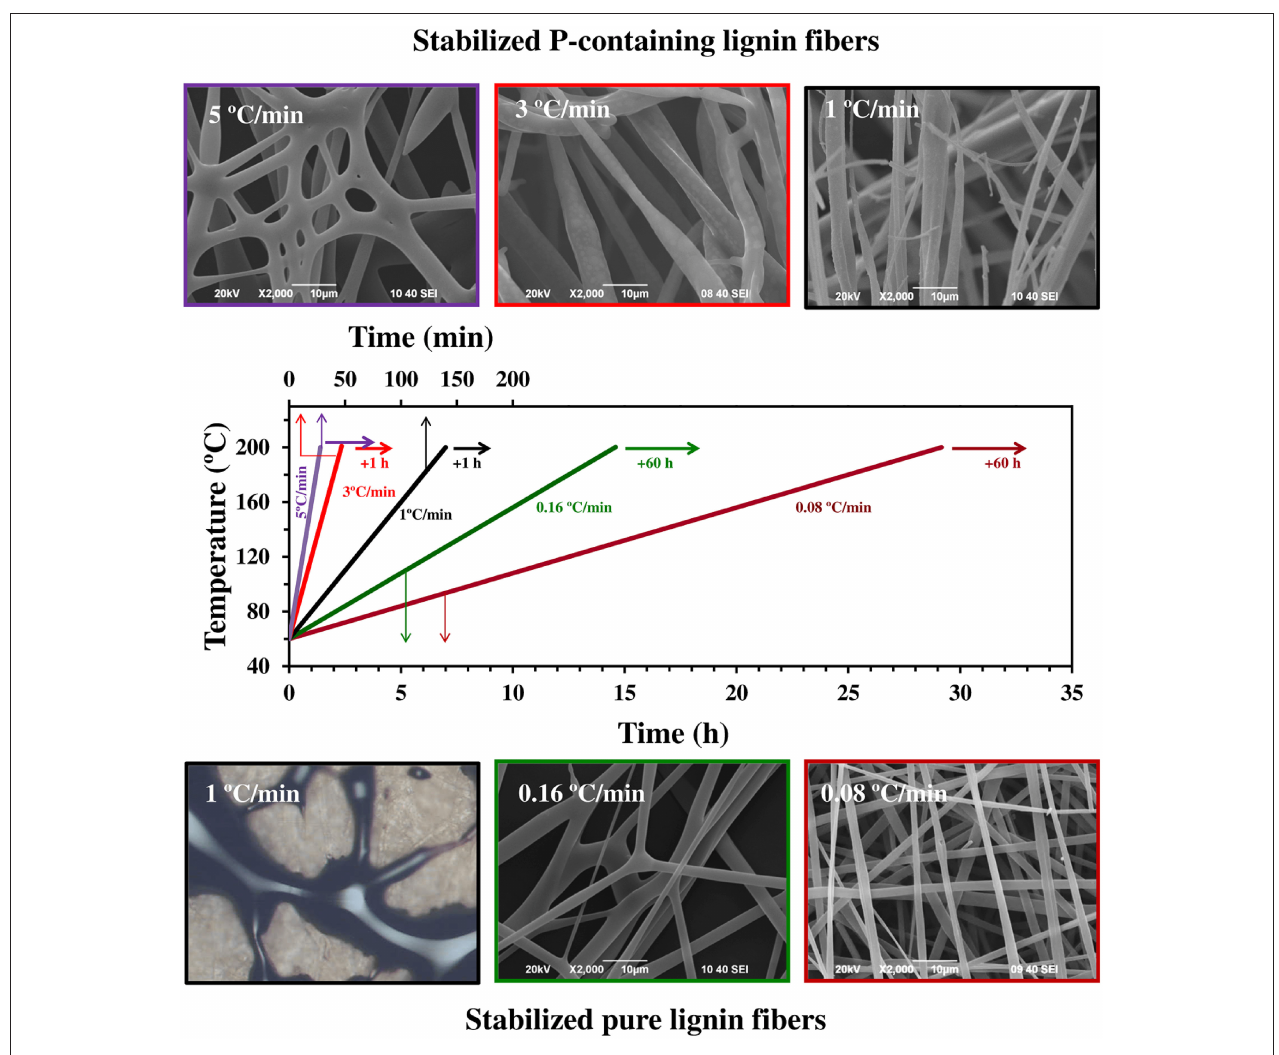
FIGURE 5 | Effect of the heating rate on the stabilization of pure and P-containing lignin